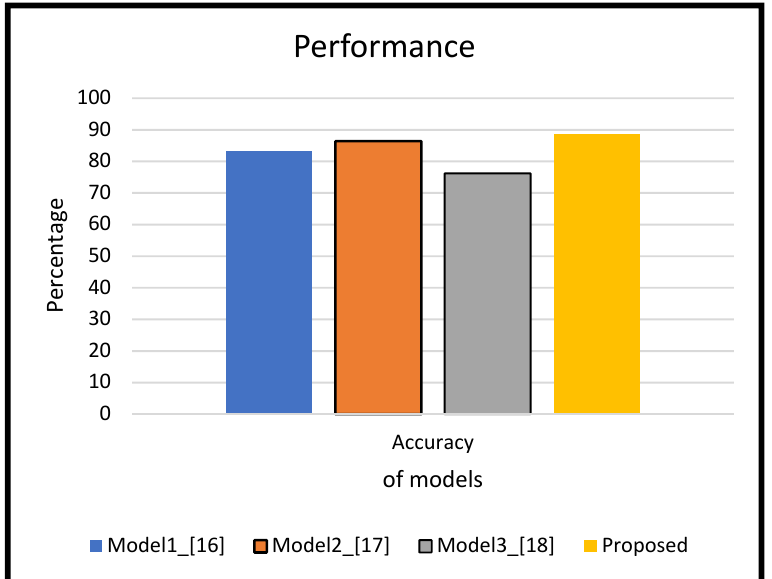
Figure 10. Comparison of the proposed model with three existing models [16–18].